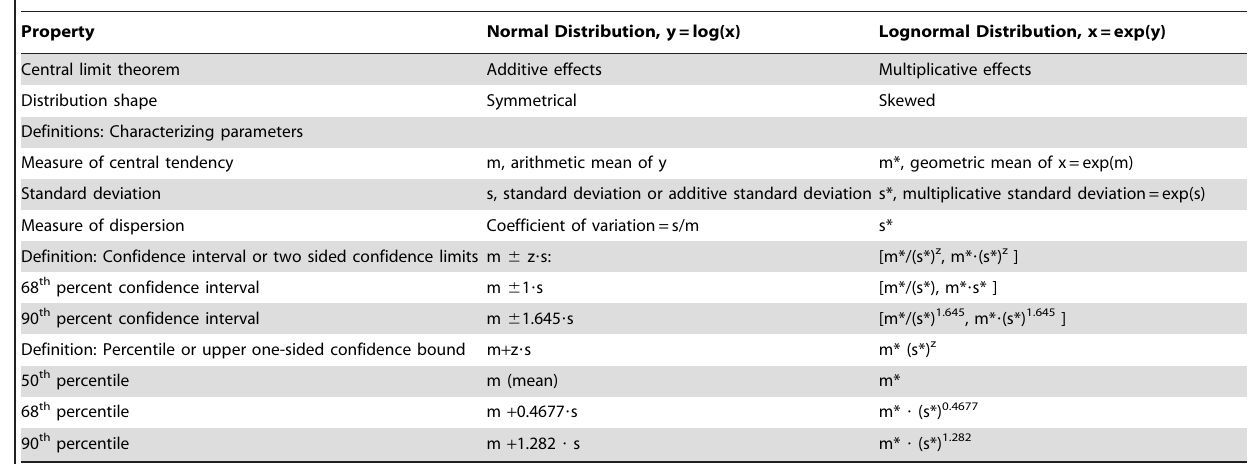
Table 2. Relationship between parameters characterizing normal (y) and lognormal (x) distributions.